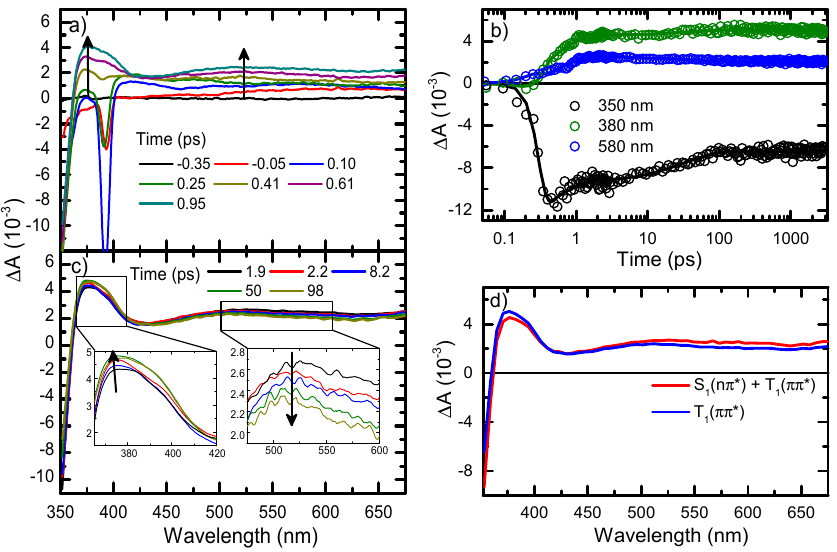
Figure 5. Transient absorption spectra of 6tGua in PBS from ( a ) sub-picosecond to ( c ) picosecond time-delays following 345 nm excitation. The negative signals from ca. 380 nm to 400 nm ( a ) are due to stimulated Raman emissions from the solvent, and are observed within the cross correlation of the pump and probe beams; ( b ) Representative kinetic decay traces of 6tGua in PBS out to 3 ns at indicated probe wavelengths; ( d ) Decay-associated spectra of 6tGua in PBS generated from global analysis using a sequential model.